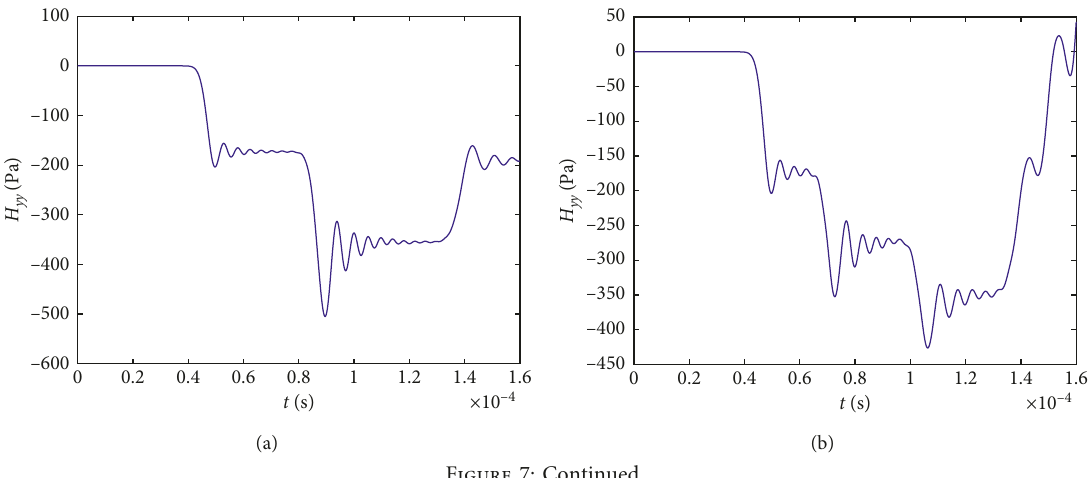
Figure 6: Normal stress of fluid field versus time (a) at the point A towards the right in the horizontal direction; (c) at the point A from [11], copyright 2017 with permission from Springer